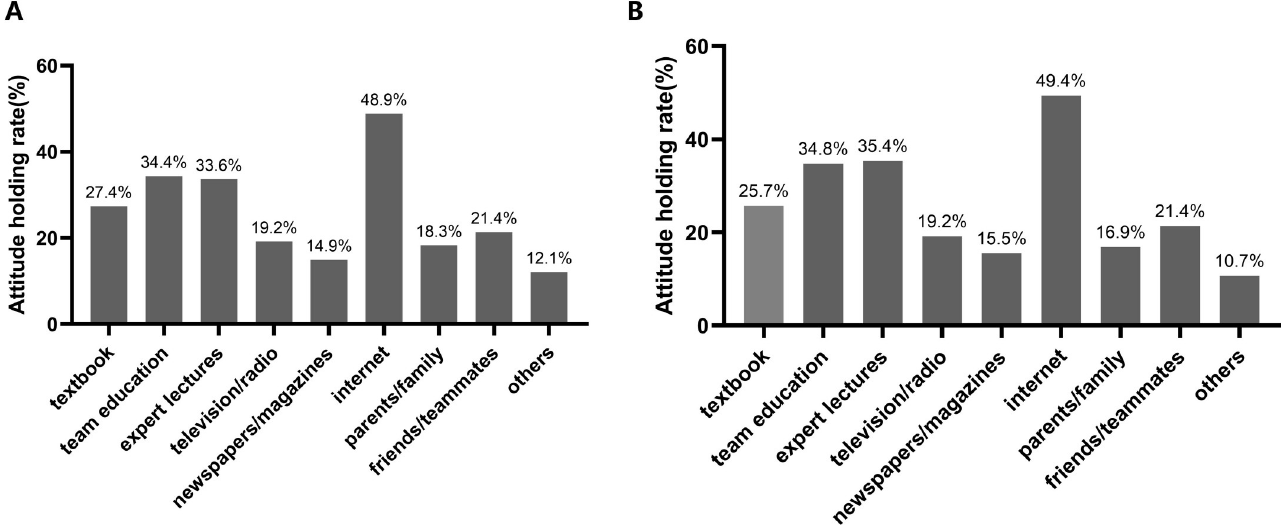
Fig 1. The desirable ways of knowledge. (A) The desirable ways of knowledge on fluid replacement; (B) The desirable ways of knowledge on urination behavior.